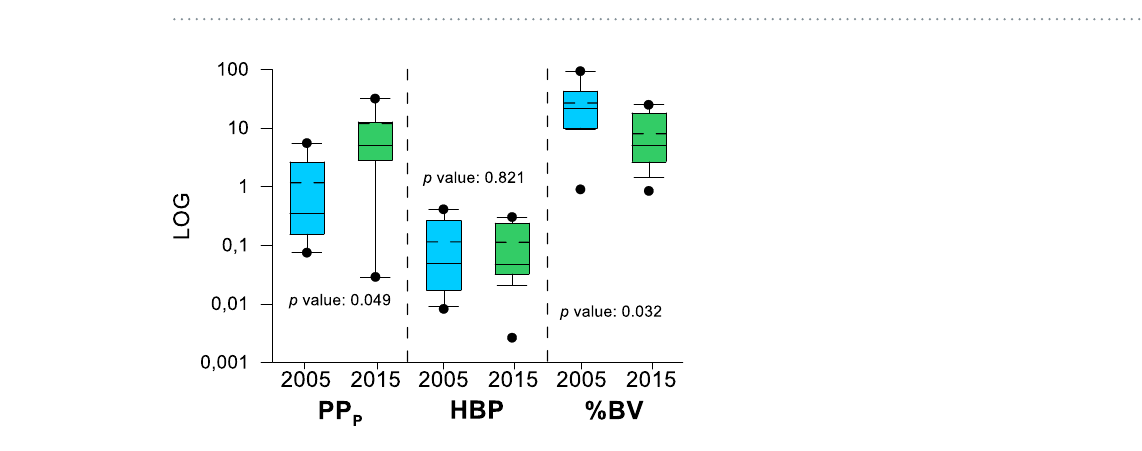
Table 1. Characterization of high-mountain lakes of Sierra Nevada for 2005 and 2015. Units are given in brackets. TDP: Total dissolved phosphorous, TDN: Total dissolved nitrogen, DOC: Dissolved organic carbon, BA: Bacterial abundance.